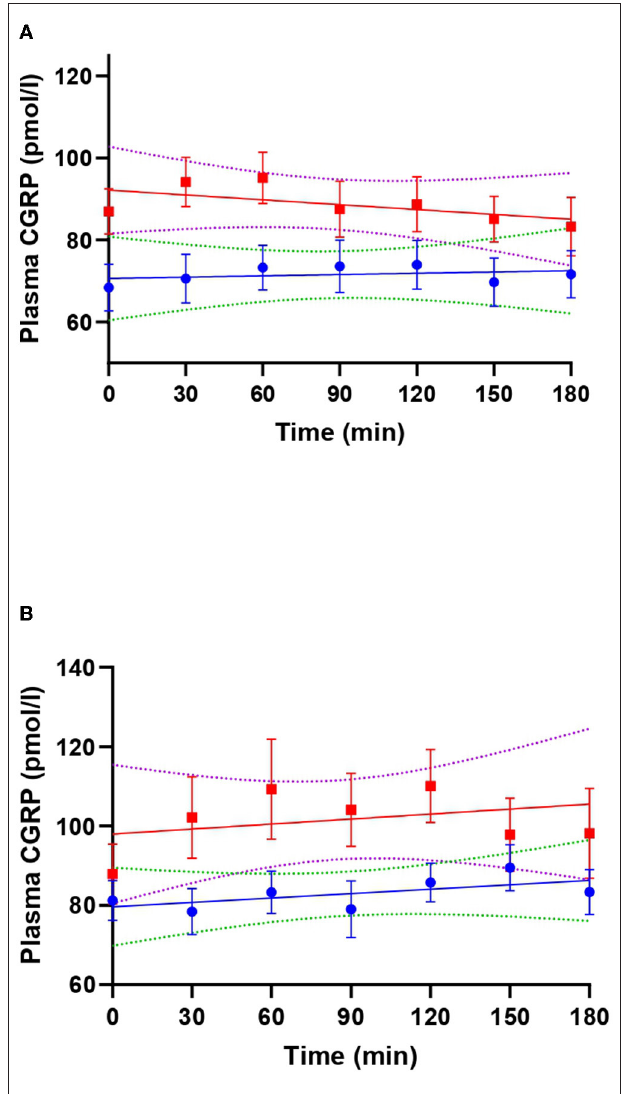
FIGURE 2 | Linear regression lines of plasma calcitonin gene-related peptide (CGRP) during VIP (red) and placebo days (blue) in patients with migraine (A) and healthy individuals (B) . Dotted lines represent the 99% confidence bands of the best fit-line. In (A) , T 30 (adjusted p -value = 0.039) and T 60 (adjusted p -value = 0.027) were significantly different from T 180 during VIP